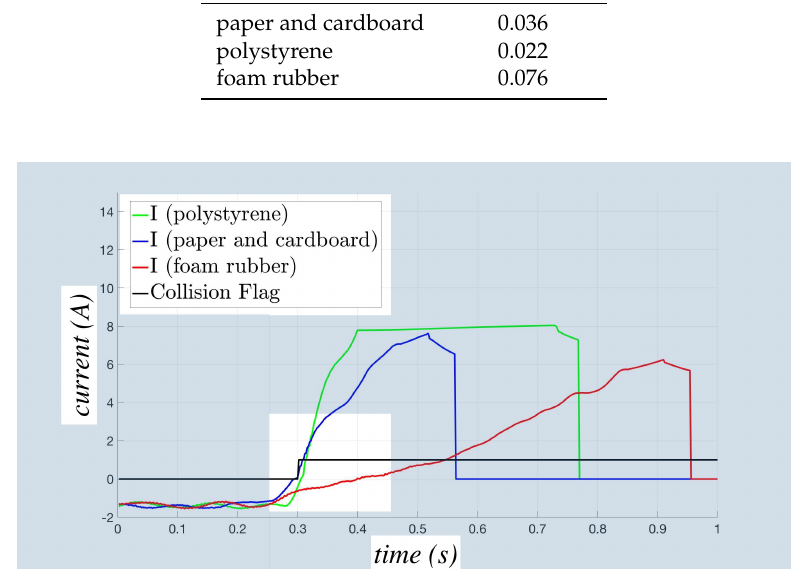
Figure 15. Behavior of the current I during the collisions for three different